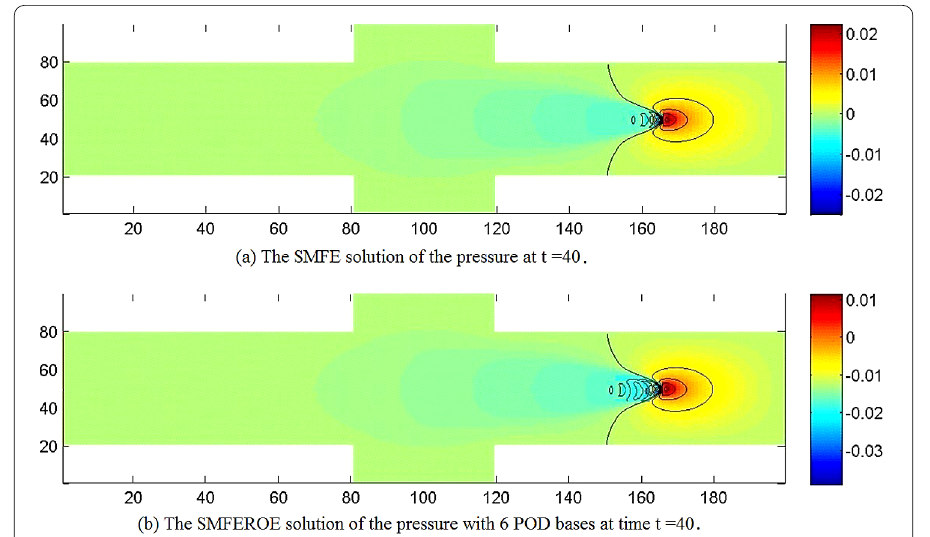
Figure 3 The numerical solutions of the pressure. (a) The SMFE solution of the pressure p at t = 40 when Re = 1,000 and Pr = 7. (b) The SMFEROE solution of the pressure p with 6 POD bases at time t = 40 when Re = 1,000 and Pr = 7.